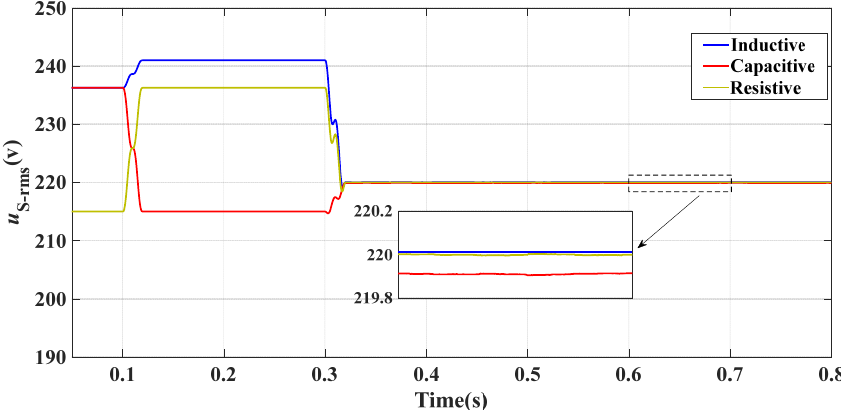
u Figure 7. RMS of u S when the control-voltage switching item u inm_sw uses a saturation function. Figure 7. RMS of uses a saturation func- u when the control-voltage switching item inm_sw S tion. u S u sinusoidal and the RMS stable at S greater than the corresponding values for the ASMC.